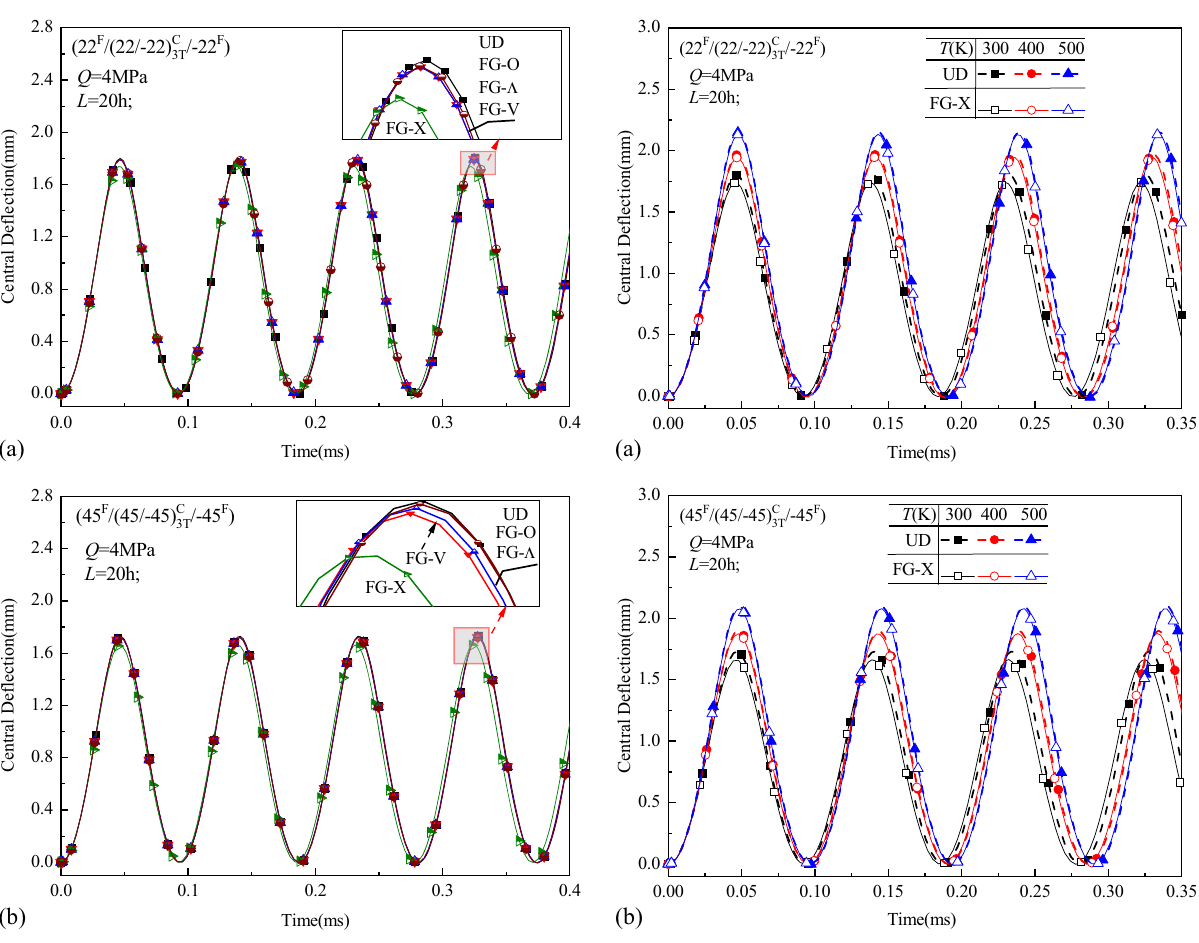
Figure 12: Forced vibration curves for FG hybrid plates. Figure 13: E ff ect of T on forced vibration of hybrid laminated plates ( T = 300, 400, and 500 K )